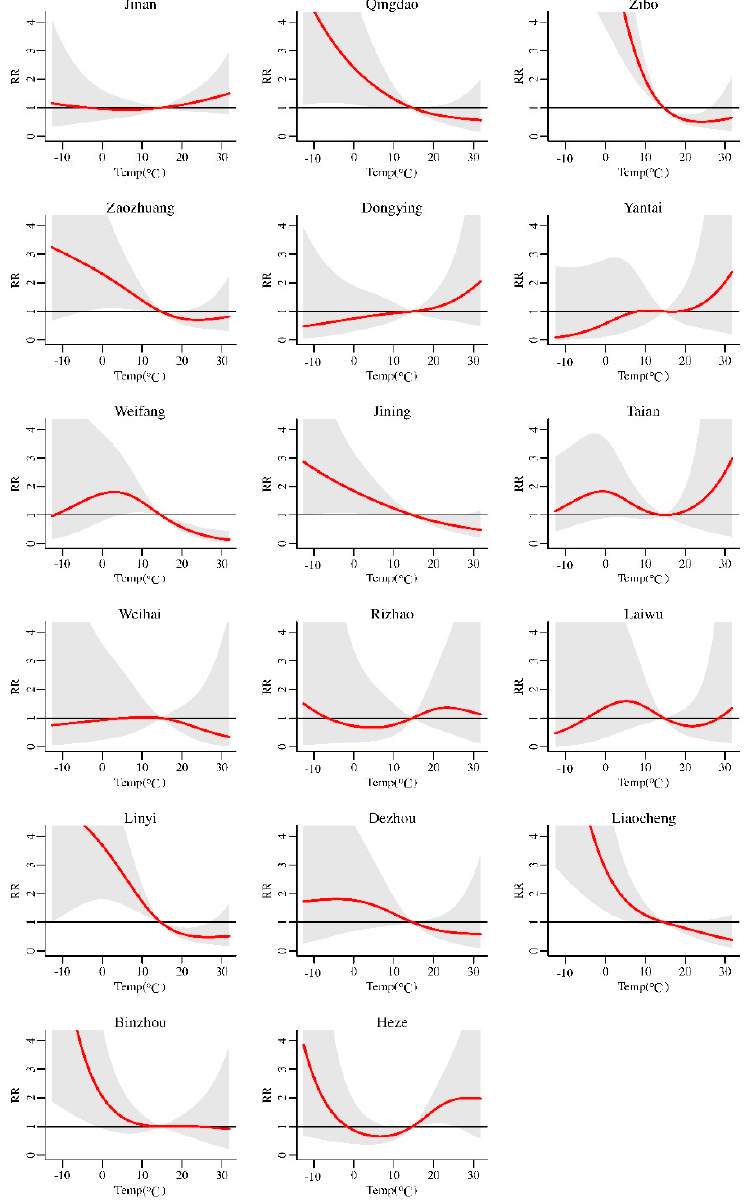
Figure 3. The cumulative RR of temperature on mumps with a 30-day lag in 17 cities in Shandong Province from 2009 to 2017.